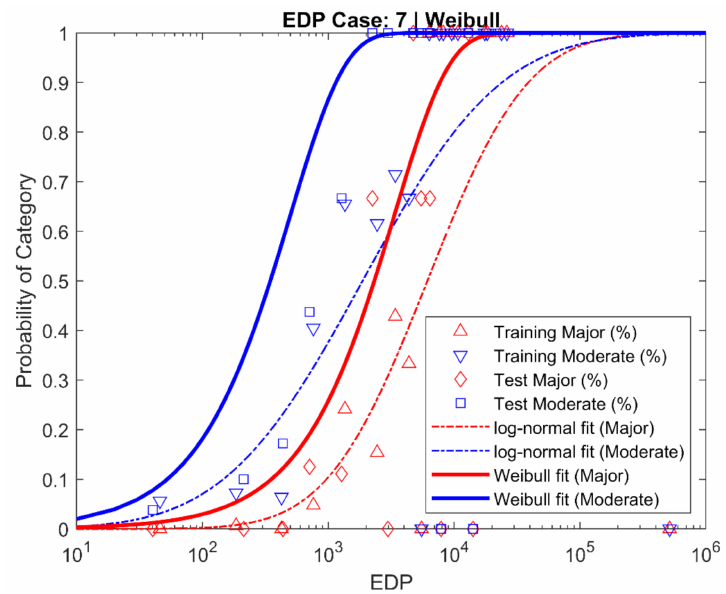
Figure 11. Comparation of Weibull (solid line) vs. log-normal distribution (dashed) for EDP 7. Observed fractions of classification are denoted by shapes and retained from previous figure to illustrate performance. Red denotes Major, Blue denotes Moderate classification.